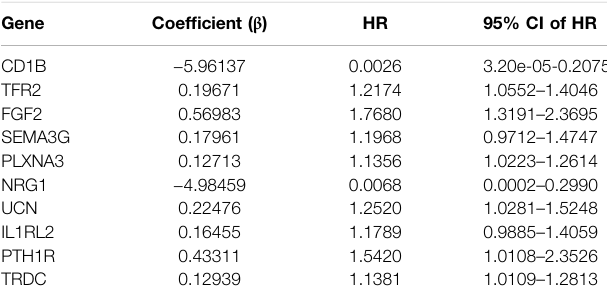
TABLE 2 | Multivariate Cox results of immune-related mRNAs based on TCGA data. Gene Coef fi cient ( β